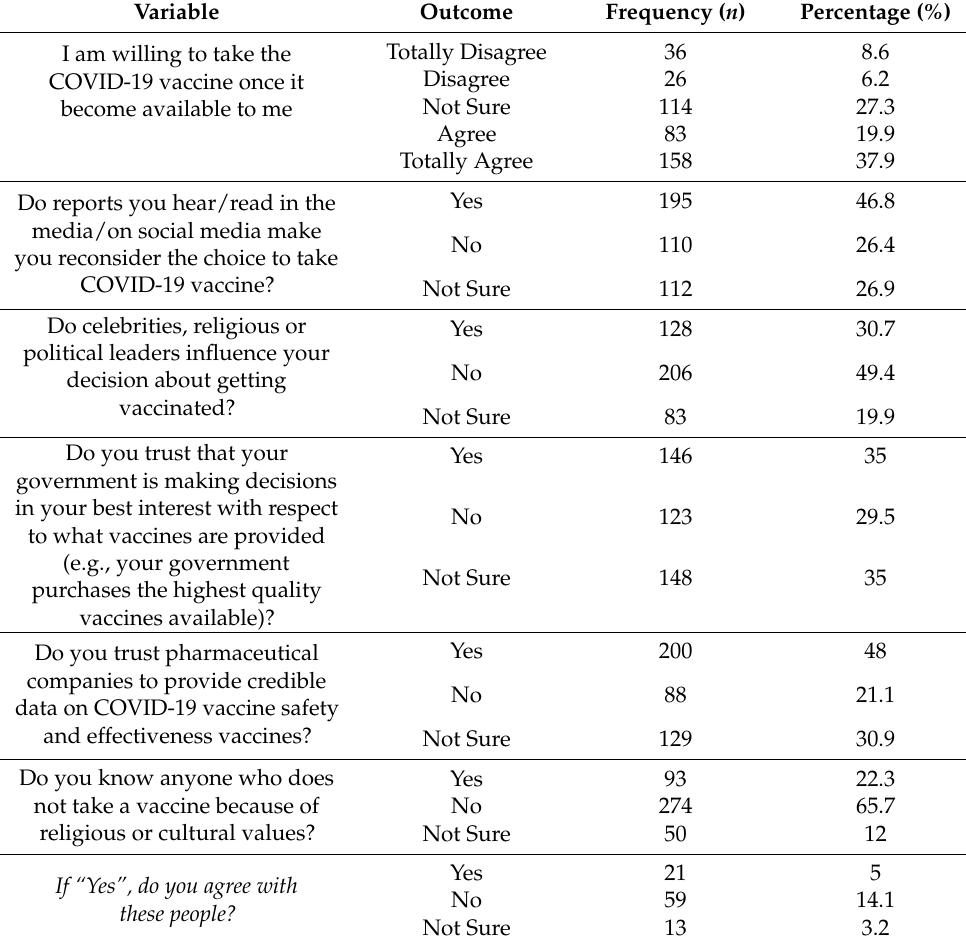
Table 4. Attitudes of Palestinian dental students towards COVID-19 vaccine, February—March 2021 ( n =